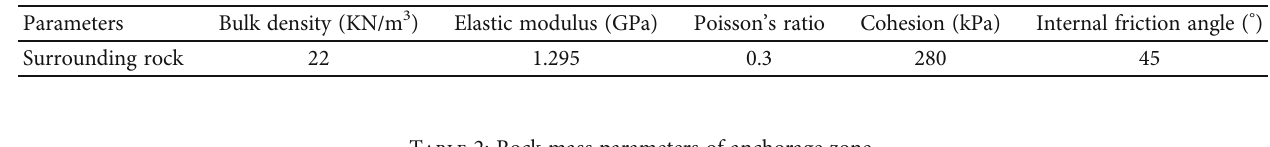
Table 1: Material parameters of surrounding rock.